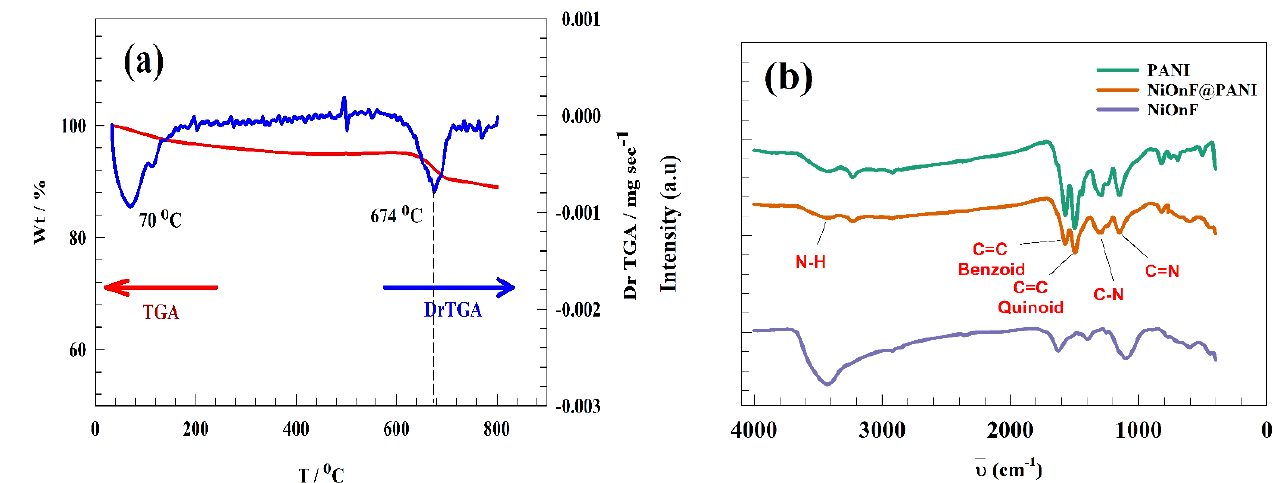
Figure 3. ( a ) TGA curve of the NiOnF, ( b ) FT-IR of PANI, NiOnF@PANI, and NiOnF.